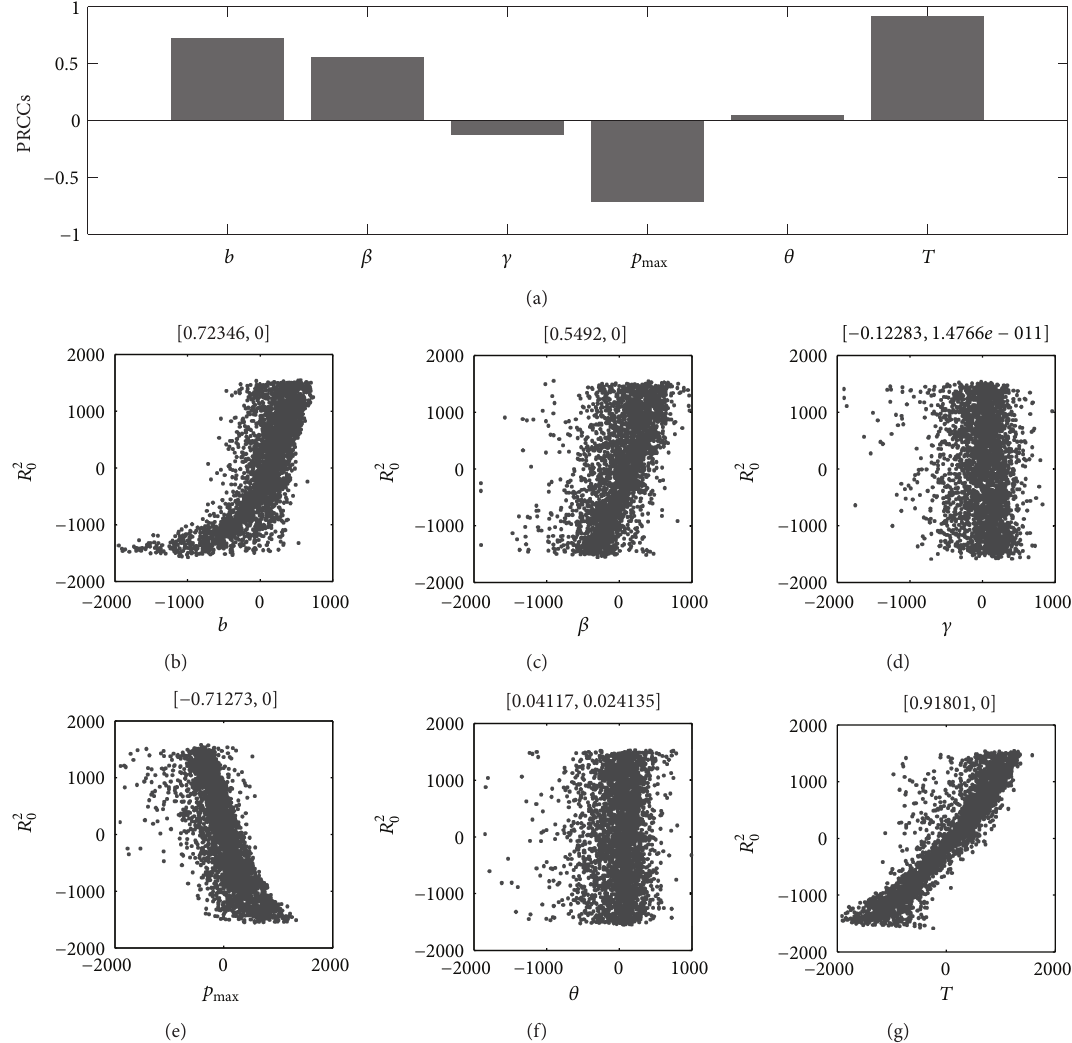
Figure 3: PRCC results and PRCC scatter plots of the baseline parameters as those shown in Table 1. Here we fix 𝑝 max = 0.75, 𝜃 = 0.2, 𝑇 = 5 . (a) PRCC results. (b–g) PRCC scatter plots. The title of each plot represents the PRCC value with the corresponding P